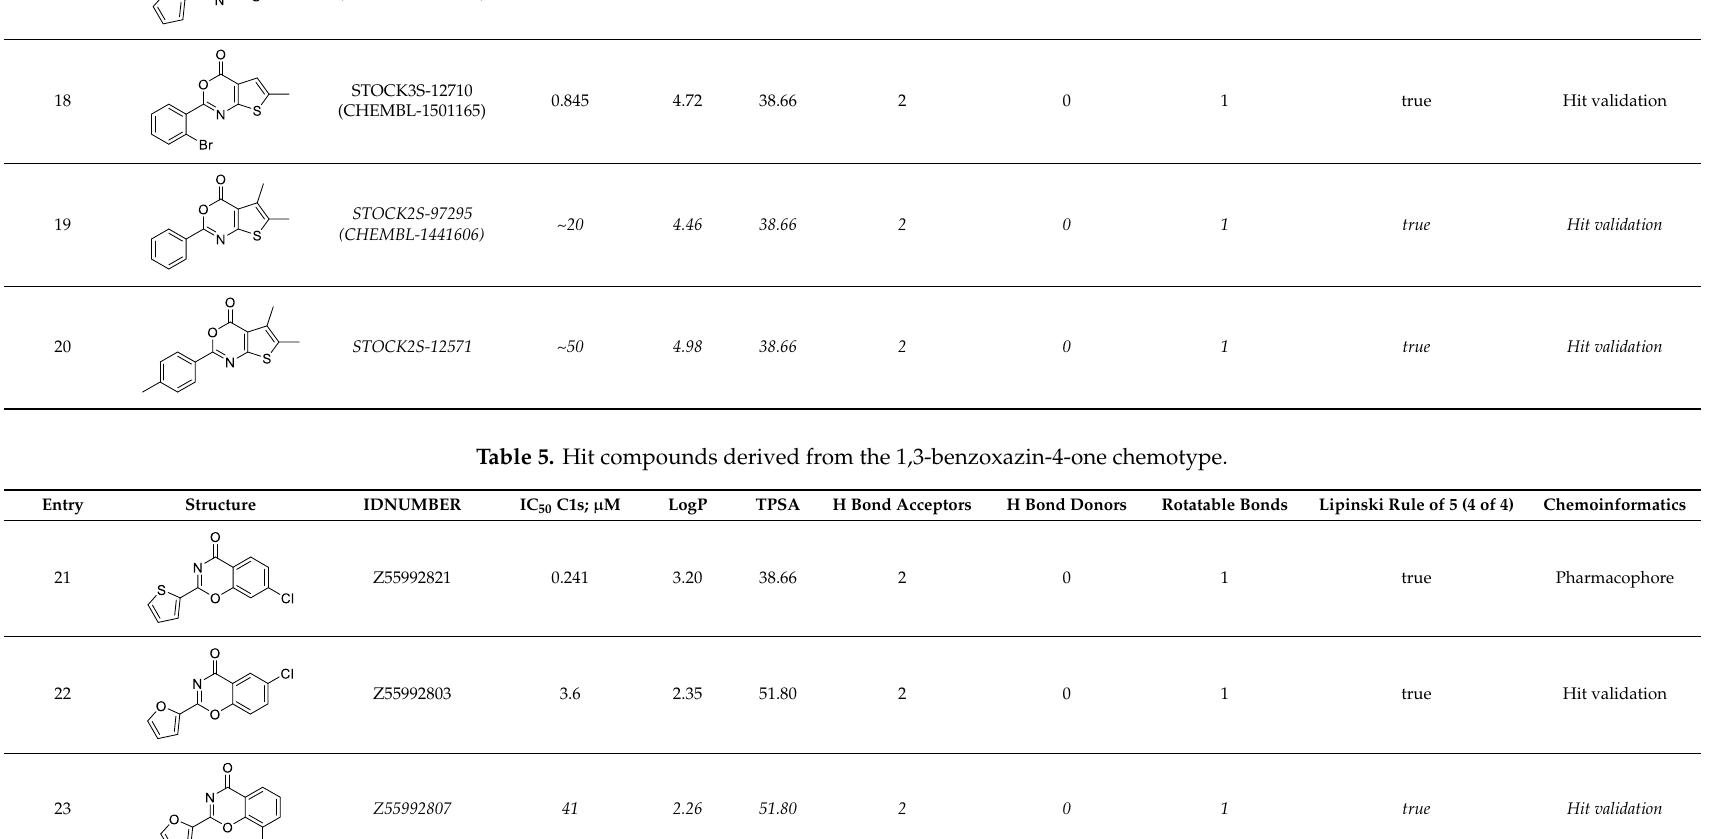
Table 6. Factor Xa inhibition of the 20 C1s inhibitor hit compounds. (Compounds with remaining activities >80 % are shown in bold).